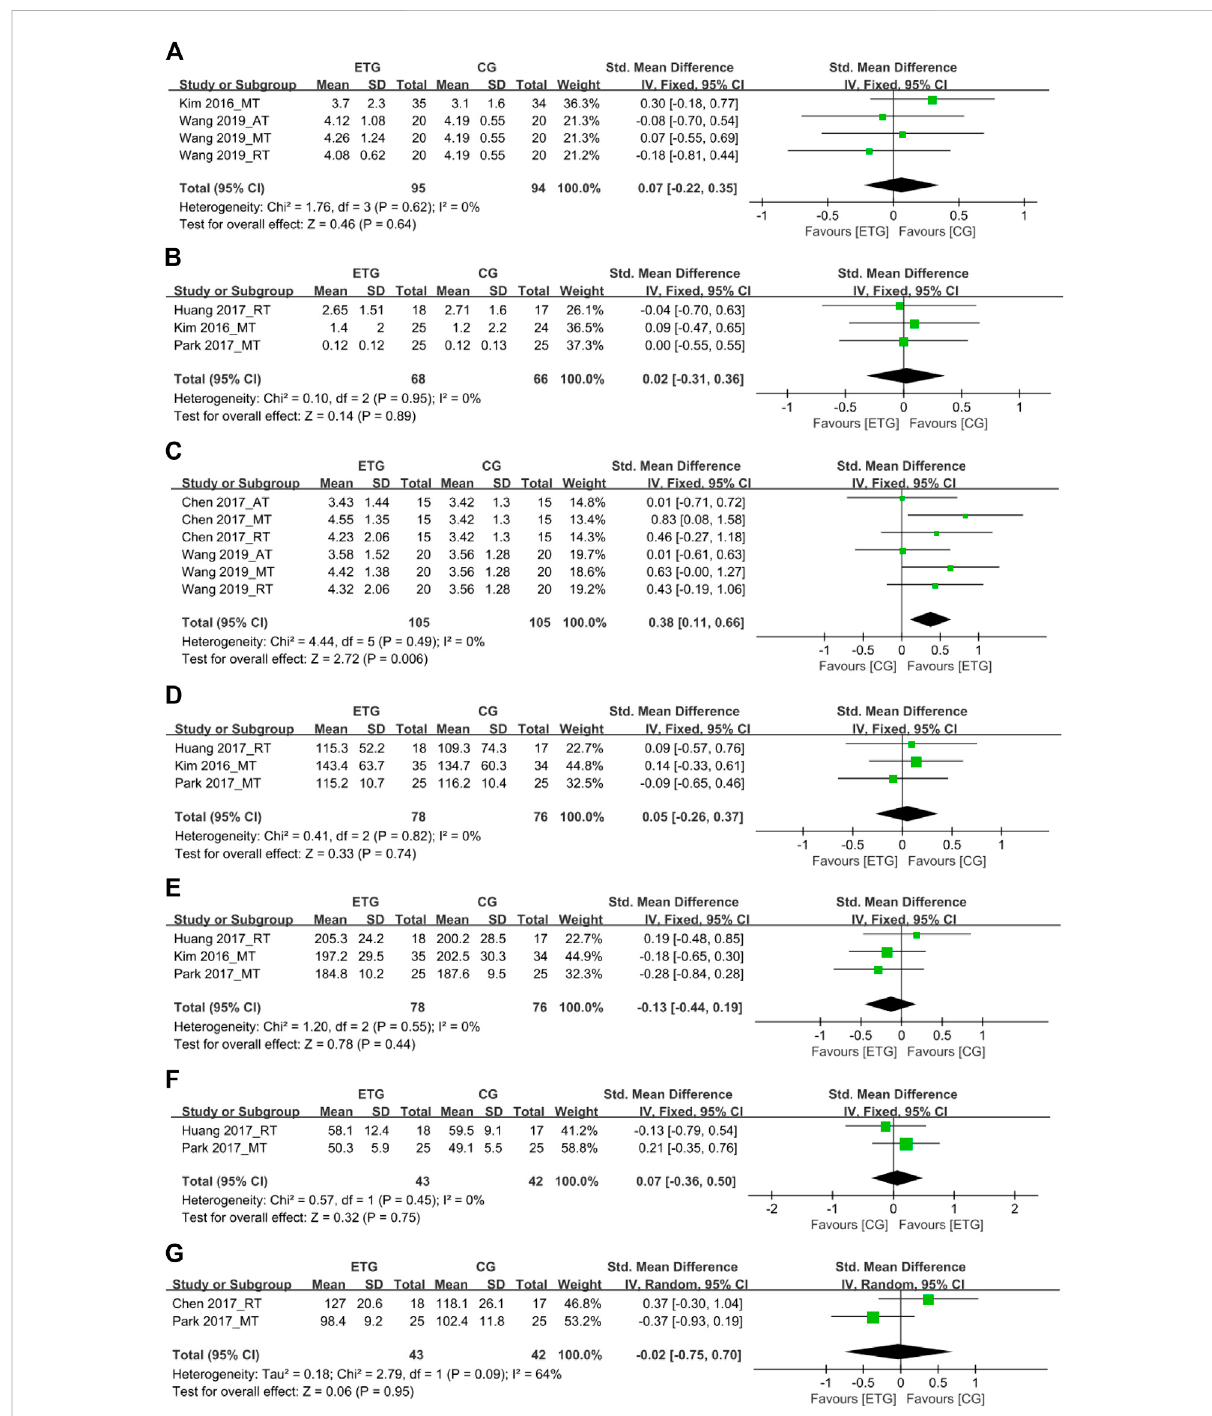
FIGURE 6 Forest plots of the comparison of the exercise training group (ETG) versus the control group (CG) on (A) interleukin-6 (IL-6); (B) C-reactive protein (CRP); (C) insulin-like growth factor 1 (IGF-1); (D) triglyceride (TG); (E) total cholesterol (TC); (F) high-density lipoprotein (HDL); (G) low- density lipoprotein (LDL); AT, aerobic training; RT, resistance training; MT, aerobic combined with resistance training; CI, con fi dence interval; SD, standard